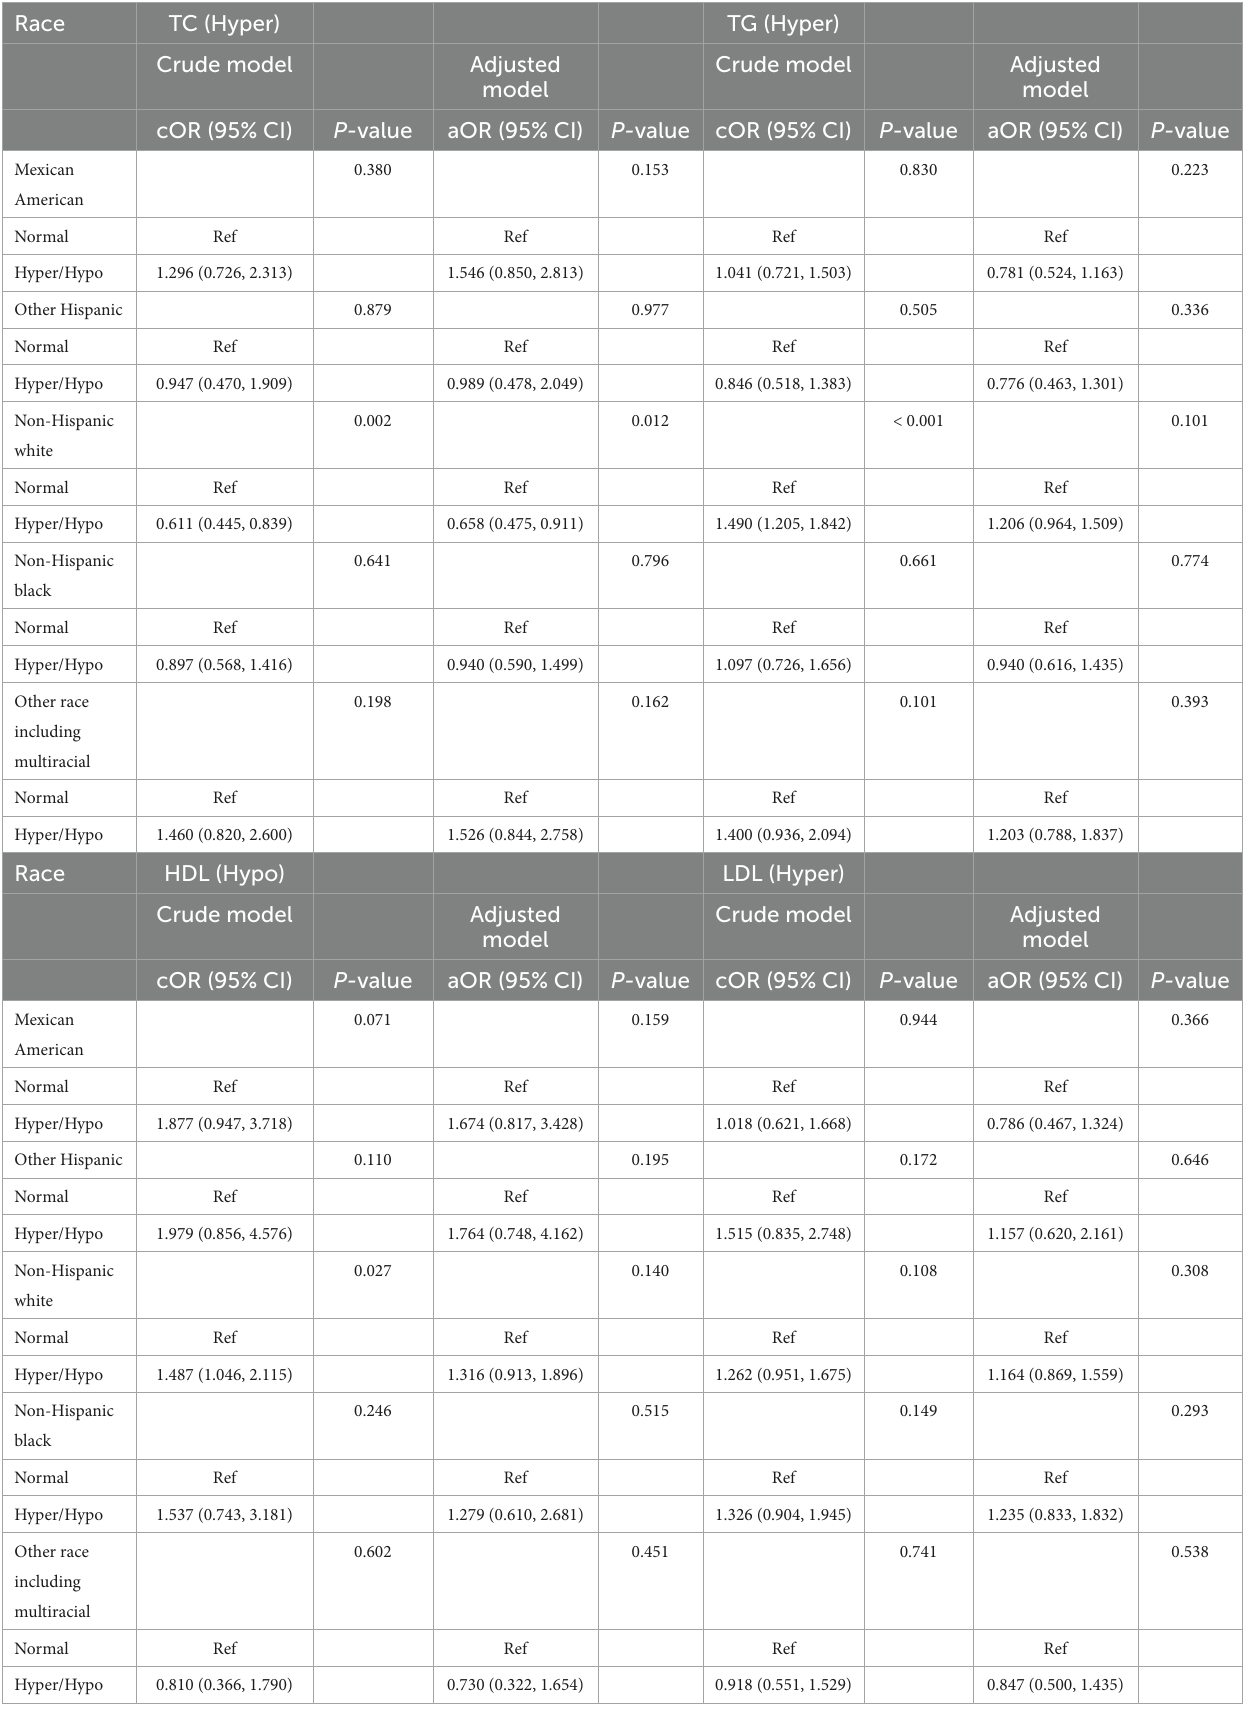
TABLE 5 Odds ratios for associations between triglyceride and cholesterol levels and anti-HBs results stratified by race.